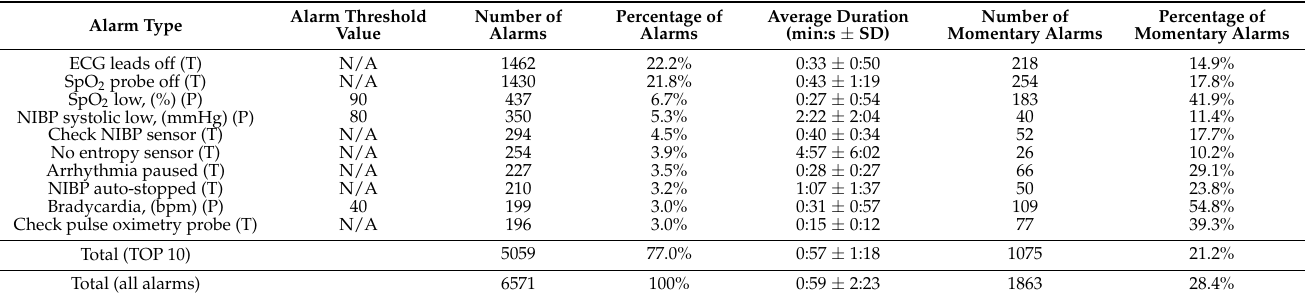
Table 1. The 10 most common alarm types out of 53.